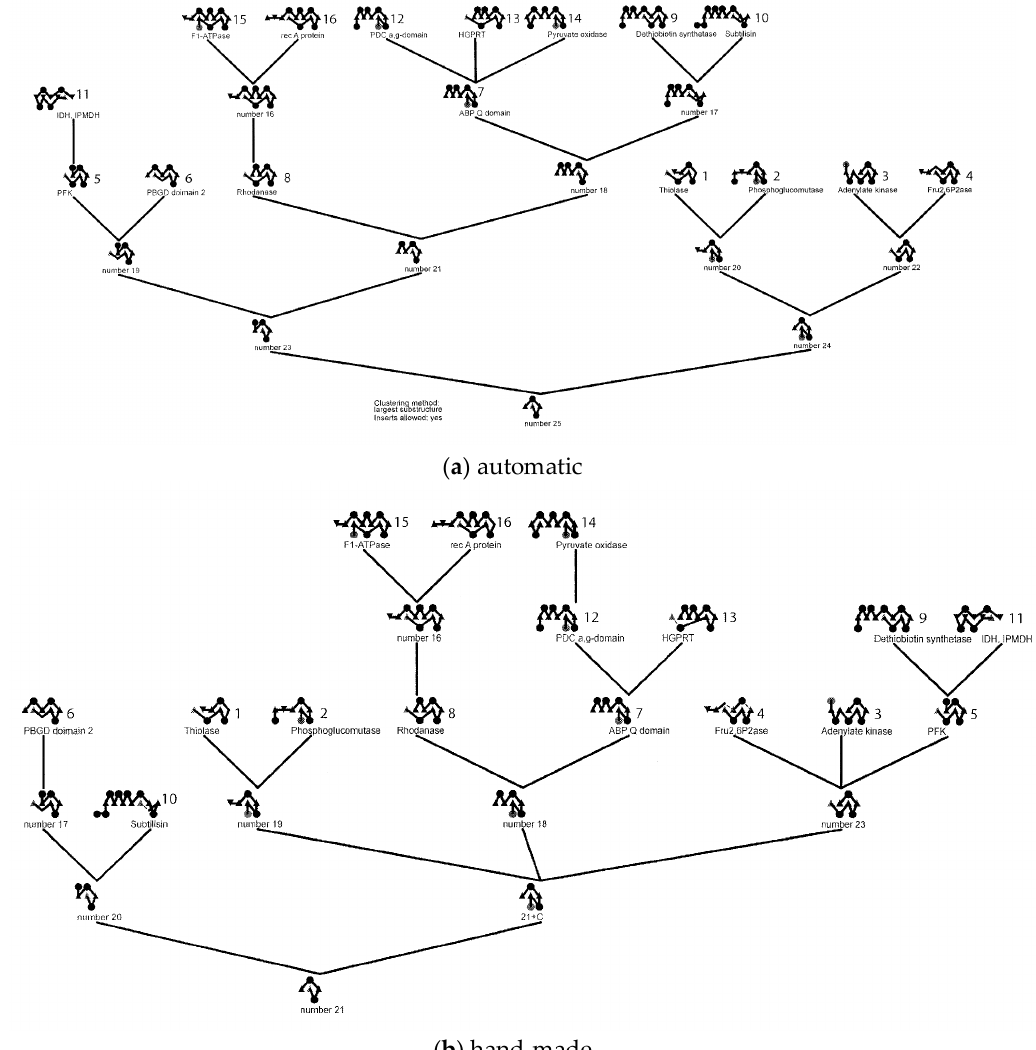
Figure 4. Fold dendrograms for alpha/beta proteins. ( a ) Calculated automatically by finding the largest common substring between topology strings which is compared in part ( b ) with Efimov’s “hand-made’” tree (based on a diagram similar to Figure 1). The 16 known structures used in the calculation are named and numbered while the “ancestral” structure nodes are just labelled as “number